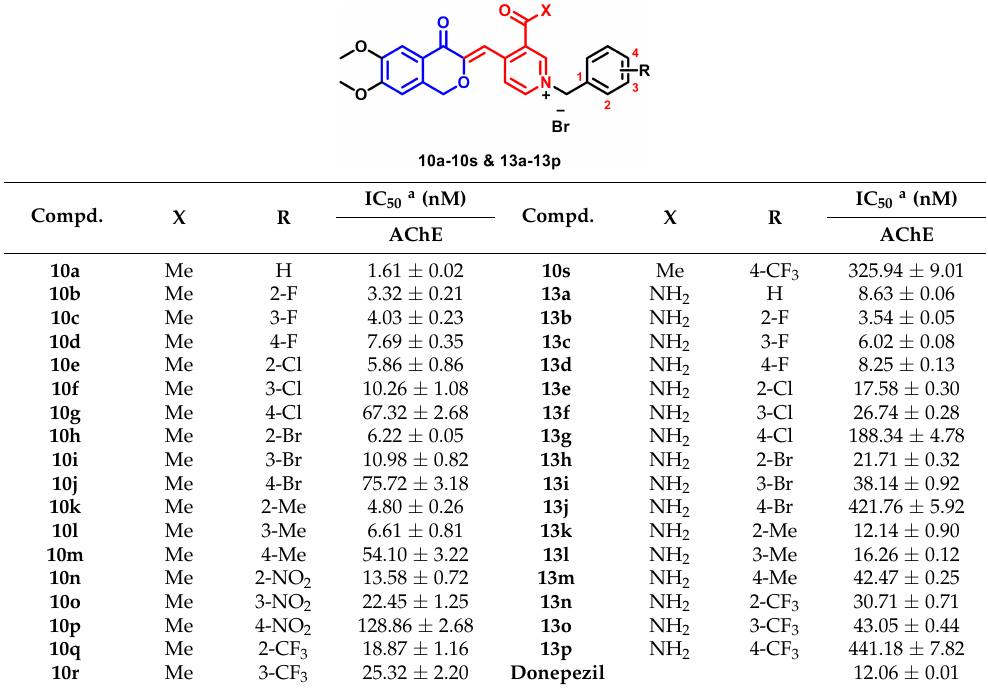
Table 1. In vitro AChE inhibitory activity of compounds 10a – 10s and 13a – 13p .